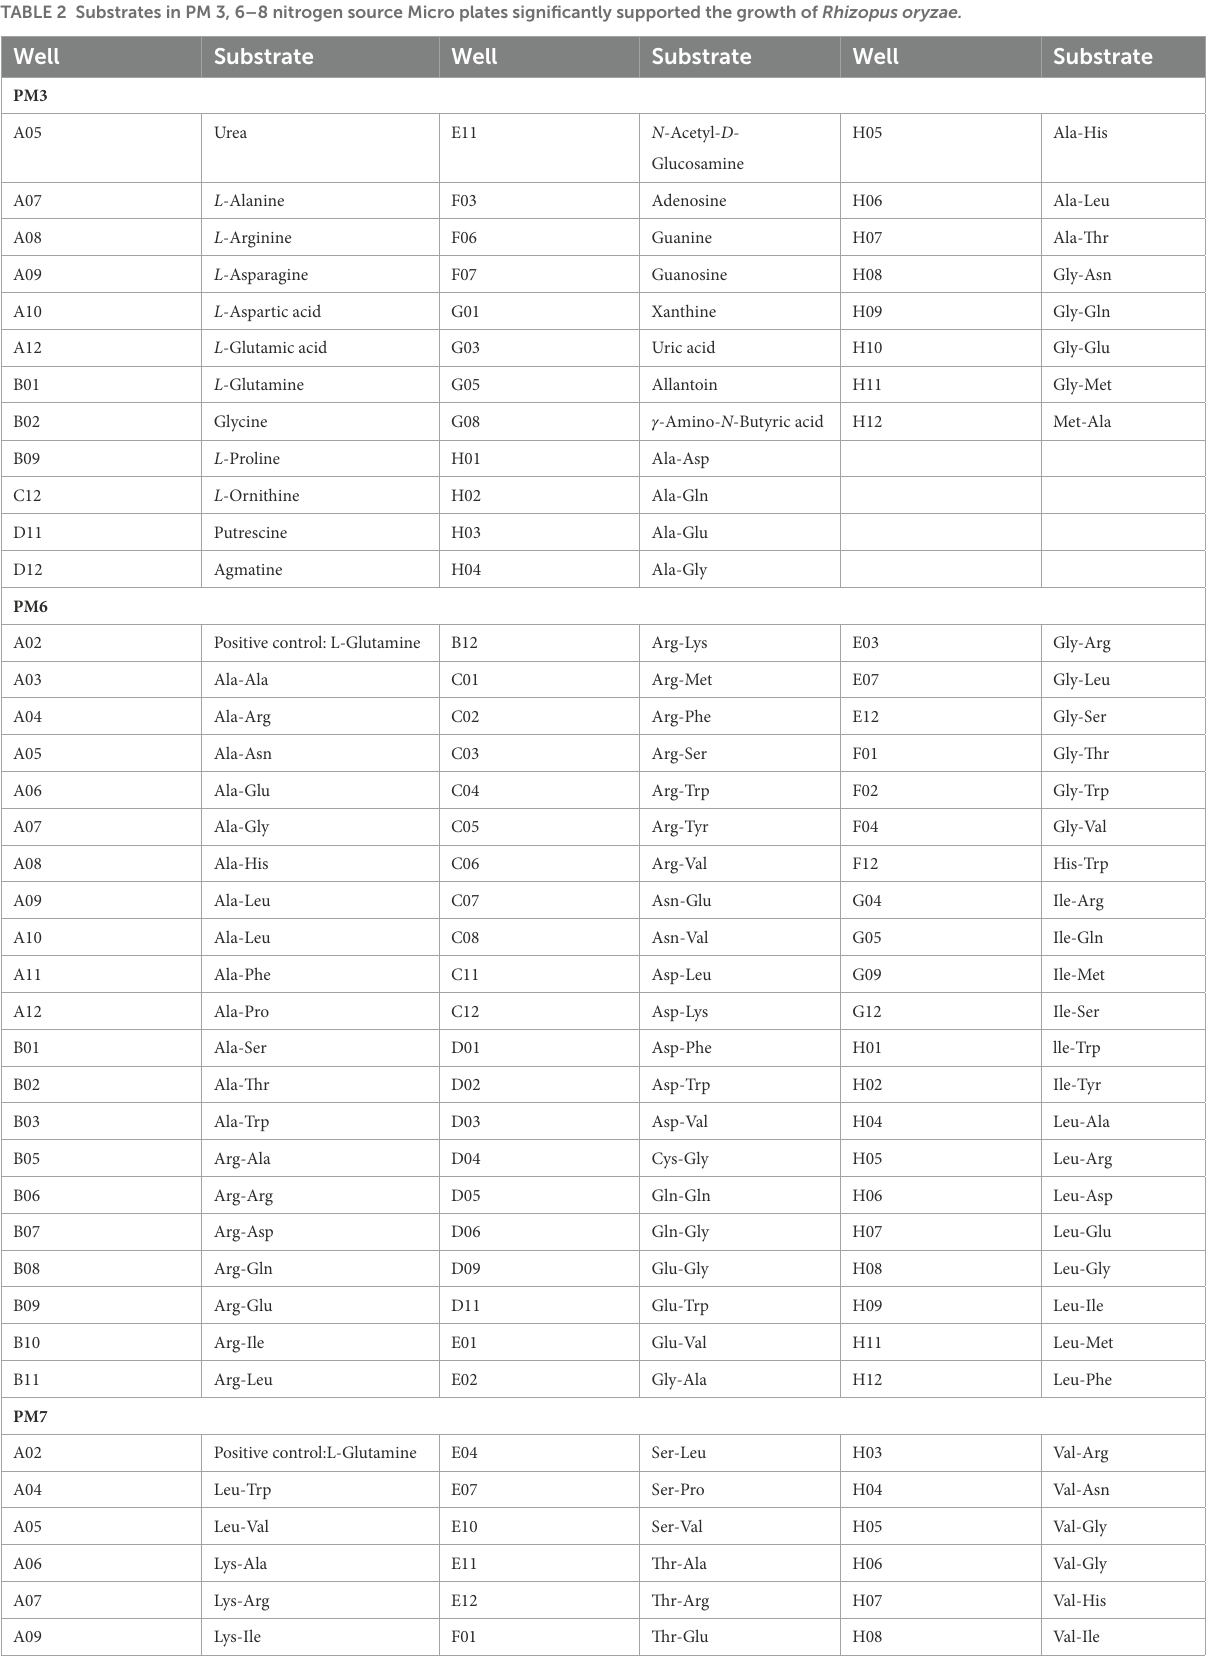
TABLE 2 Substrates in PM 3, 6–8 nitrogen source Micro plates significantly supported the growth of Rhizopus oryzae.